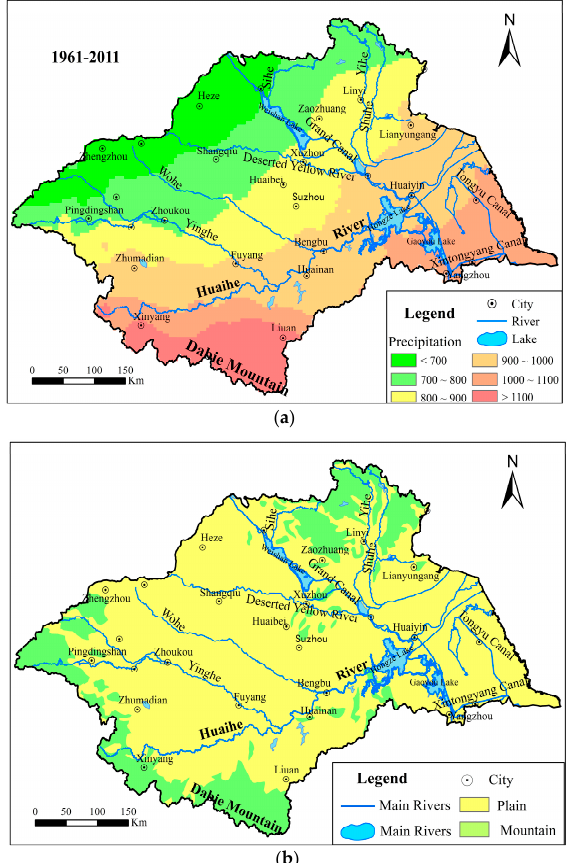
Figure 2. The spatial distribution of the average annual precipitation during 1961 to 2011 ( a ) and the main physiognomy ( b ) in the Huaihe River basin.